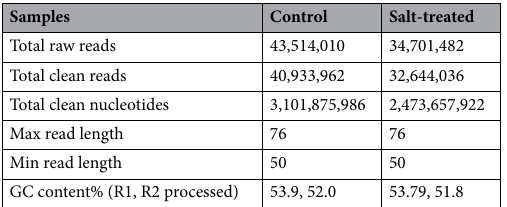
Table 1. Summary statistics of P. indica transcriptome generated on Illumina NextSeq 500 .